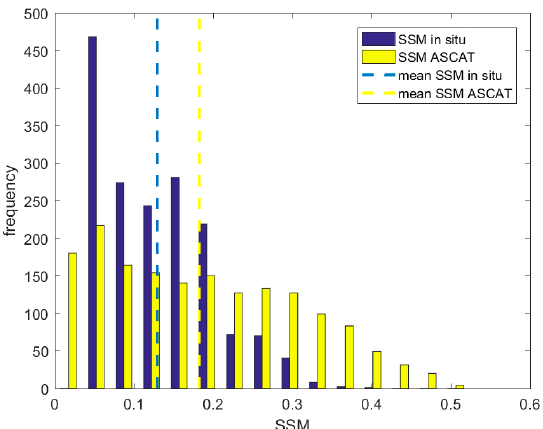
Figure 11. Histogram of Soil Moisture (m 3 m − 3 ) for all Australian sites combined for both years for in situ measurements (blue) and ASCAT measurements (yellow), mean SSM for in situ and ASCAT are presented.